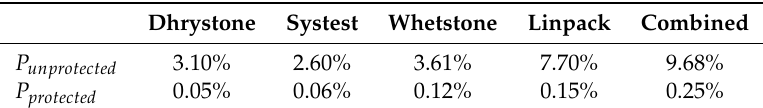
Table 5. Not-normalized percentage of undetected errors for both unprotected and DTMR-protected versions of the Rocket RISC-V processor.